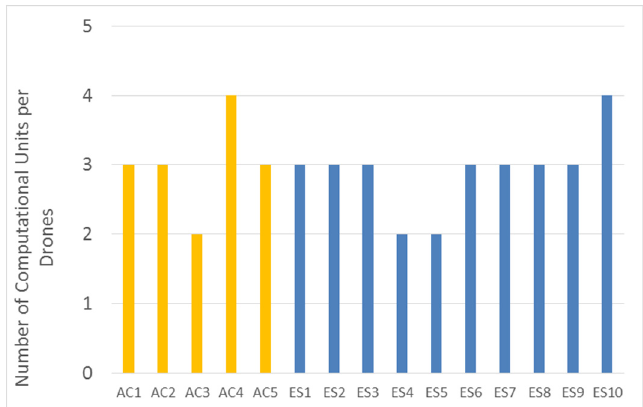
Figure 9. Number of needed computational units per drone.